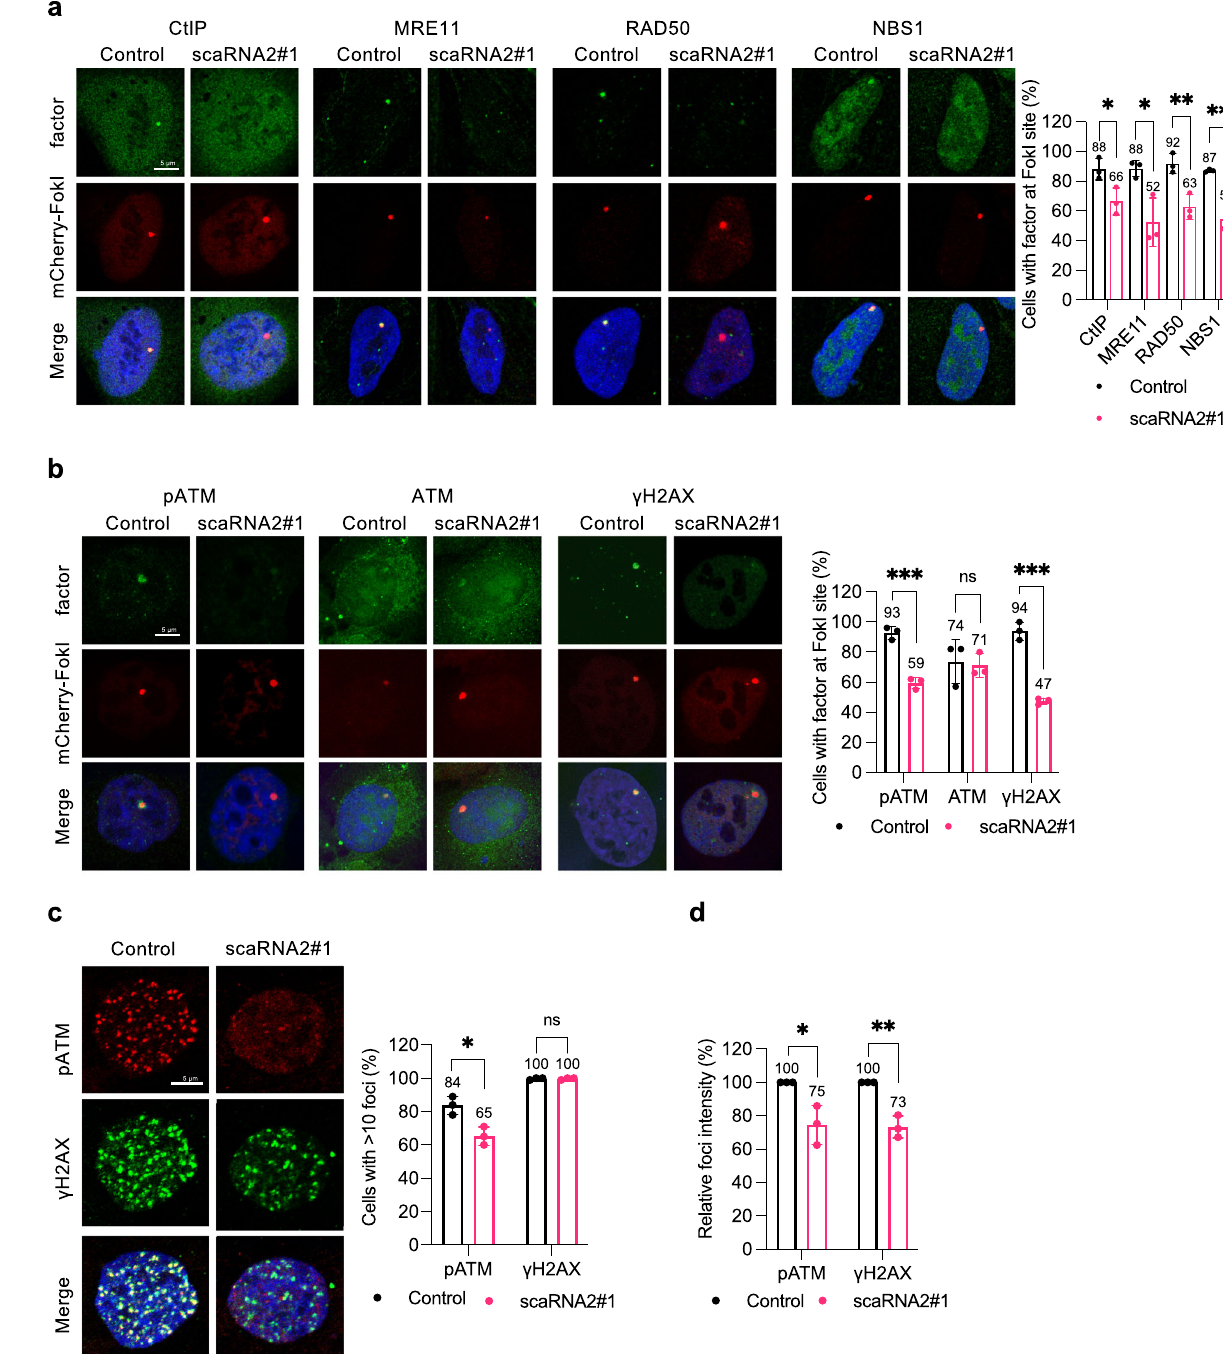
Fig. 3 Loss of scaRNA2 reduces ATM activation and recruitment of the MRN complex at DNA double-strand breaks. a , b Immunostaining of the repair proteins indicated in U2OS FokI cells transfected with GapmeRs for 48 h and treated with Shield and 4-OHT for 4 h. The graph shows the percentage of 50 cells (means ± SD n = 3) in which the protein indicated co-localized at the FokI site, * p < 0.05, ** p < 0.01, *** p < 0.001, ns (not signi fi cant) as determined by unpaired two-tailed t-test. The images depict a representative cell exhibiting the potential change in phenotype. c Immunostaining of the repair proteins indicated in U2OS cells transfected with GapmeRs for 48 h and then irradiated (2 Gy, 1 h recovery). The graph illustrates the percentage of 100 – 200 cells (means ± SD n = 3) whose nuclei contained > 10 IR-induced foci, * p < 0.05, ns (not signi fi cant) as determined by unpaired two-tailed t-test. d The relative intensity (control set to 100%) of pATM and γ H2AX IR-induced foci in the same cells depicted in Fig. 3c, as assessed using CellPro fi ler. The values shown are means± SD n = 3, * p < 0.05, ** p < 0.01 as determined by unpaired two-tailed t-test. Source data are provided as a Source Data fi